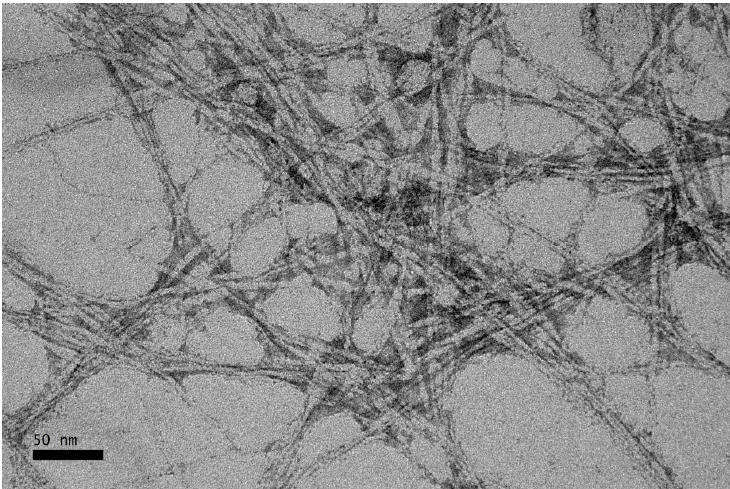
Figure 7. TEM micrograph of CNC extracted from OPMF.